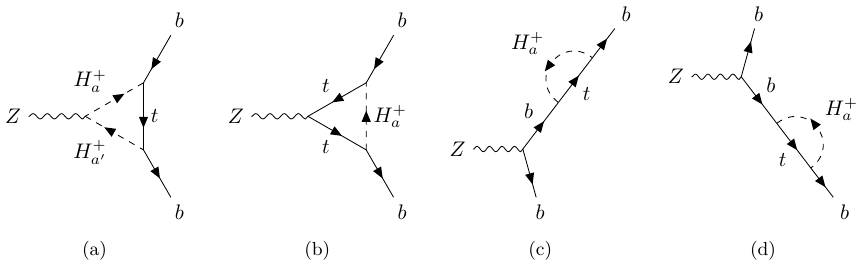
Figure 1 . Feynman diagrams that produce equations (2.10) and